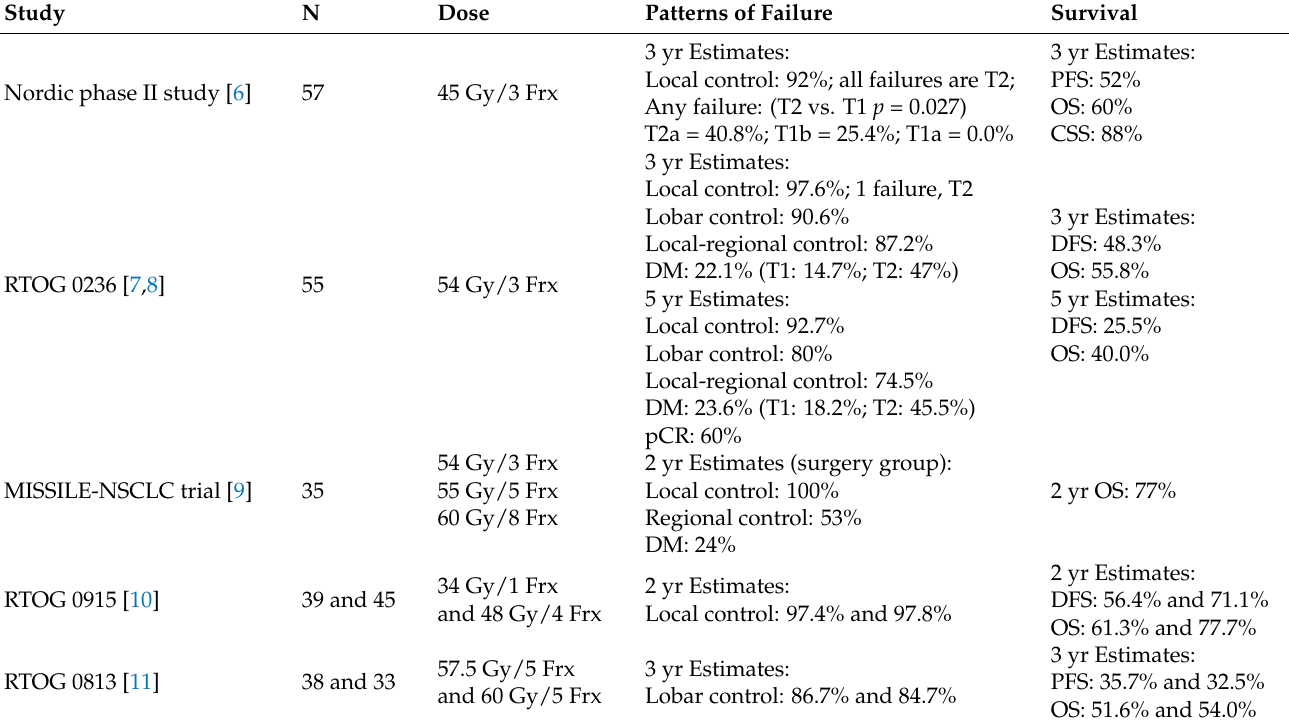
Table 1. Clinical outcome in selected prospective trials on SBRT for cT1-2N0M0